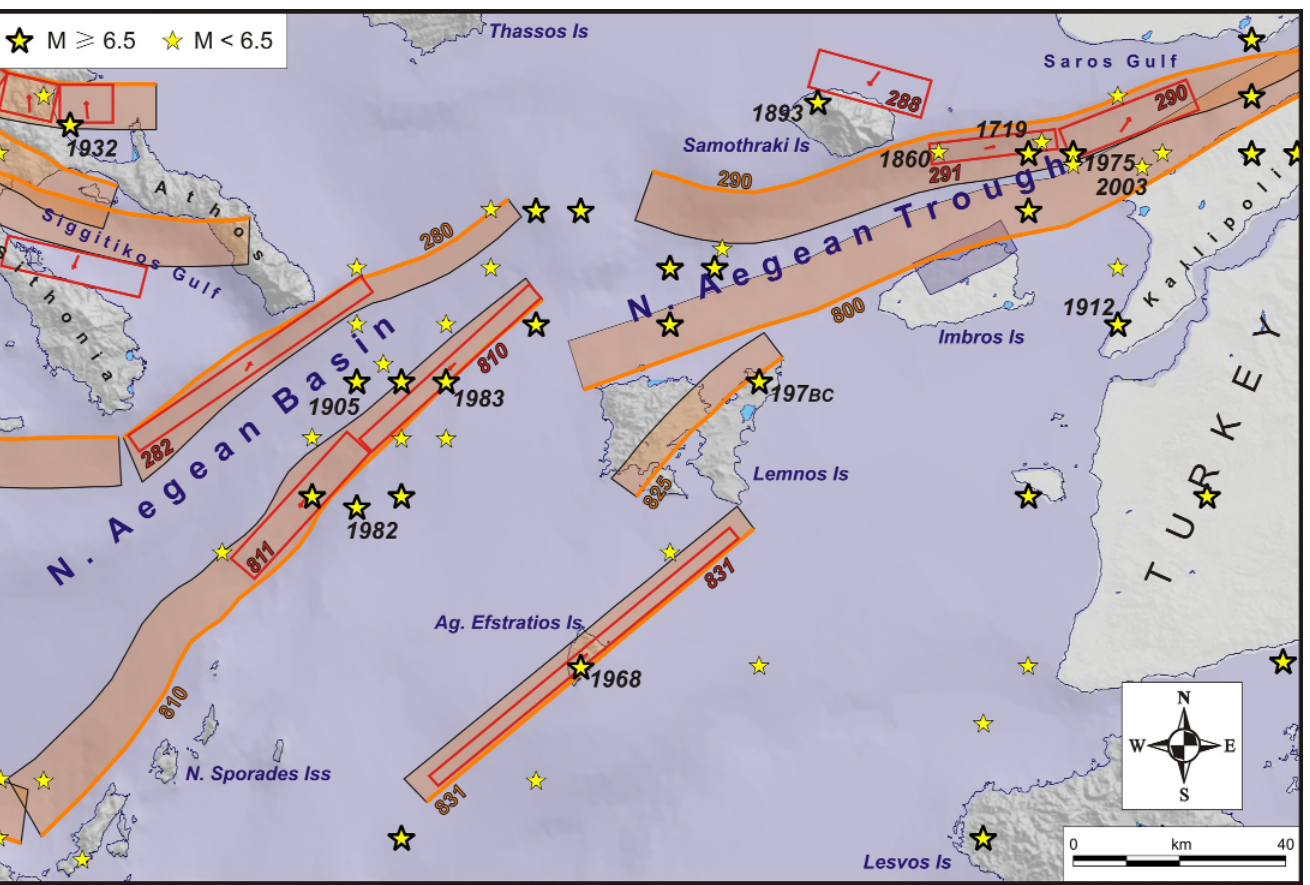
Figure 6. Map detail of the seismogenic sources belonging to the "North Aegean Sea fault system". See Figure 1 for map location and seismogenic sources. Three-digit labels refer to the database code of the seismogenic source (ISS codes in italics). Years are provided for major earthquakes discussed in main the text (see also Table